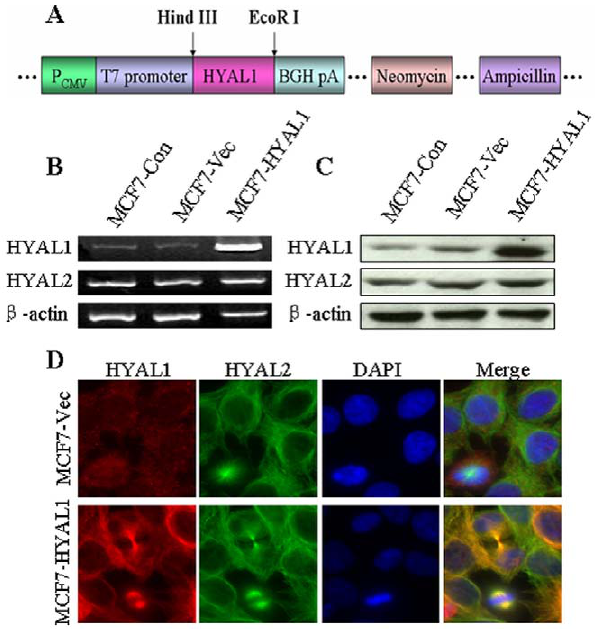
Figure 1. Identification of the recombinant plasmid. Construc- tion of the recombinant eukaryotic expression vector pcDNA3.1( + ) containing the HYAL1 gene used in the studies. The positions of the restriction enzyme digestion sites were marked (A). Transfection of the recombinant plasmid pcDNA3.1-HYAL1 or pcDNA3.1 empty vector into MCF7 cells, respectively. RT-PCR (B), Western blot (C) and immunoflu- orescence (D) analysis validated the successful transfection and the expression of the HYAL1 mRNA and protein were up-regulated in pcDNA3.1-HYAL1, the pcDNA3.1-HYAL1 did not substantially affect the HYAL2 expession.